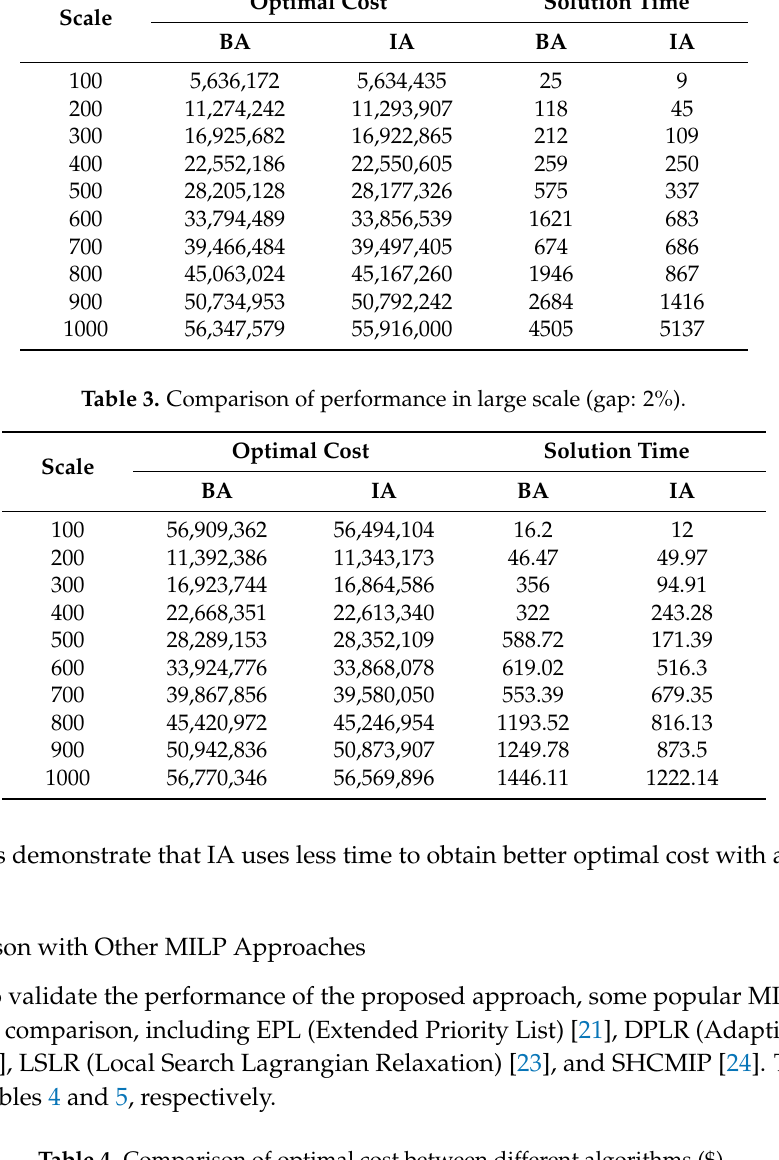
Table 4. Comparison of optimal cost between different algorithms